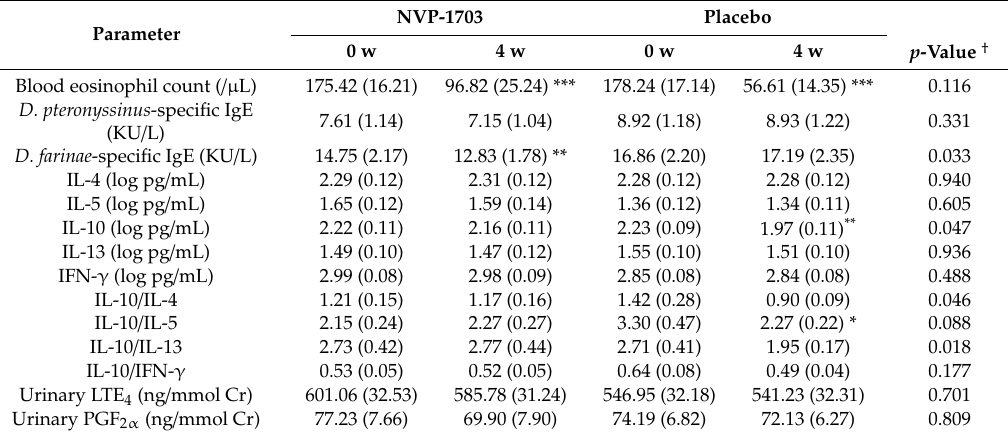
Table 4. Changes in immunological parameters.